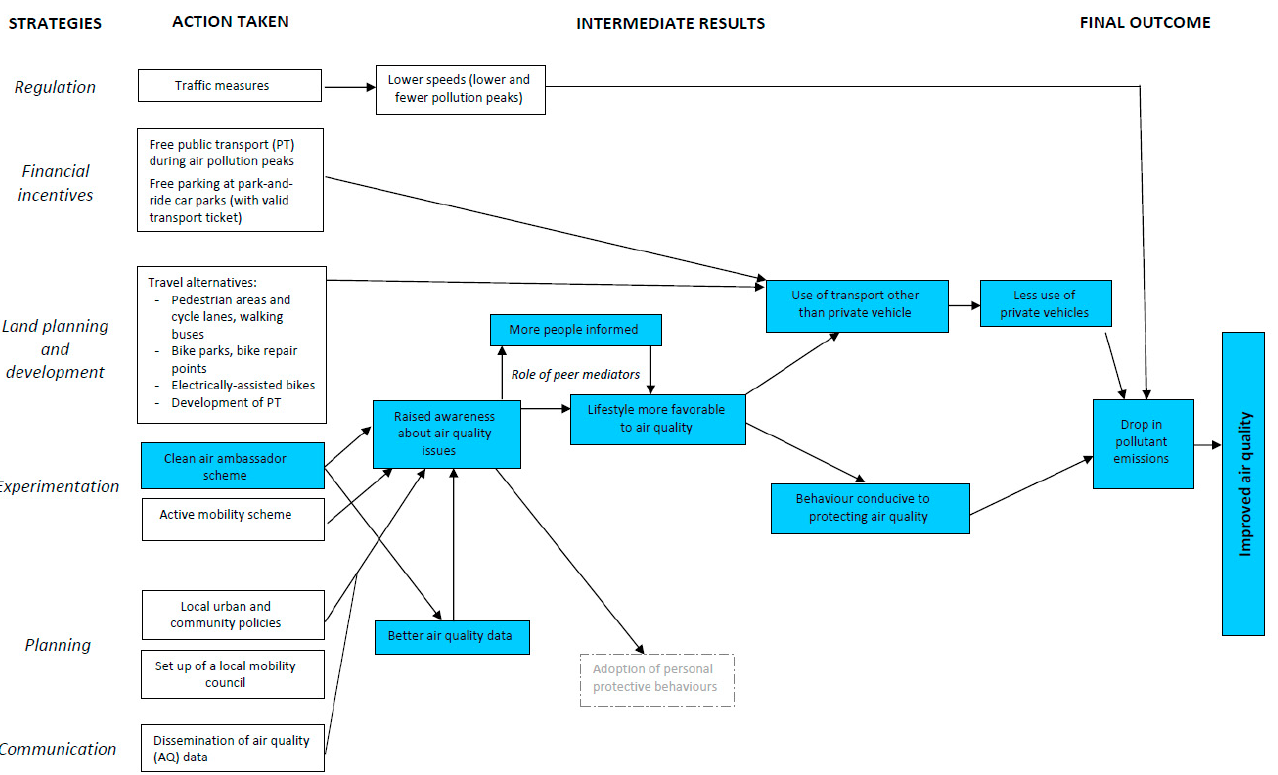
Figure 1. The intervention logic of the project and its place in local